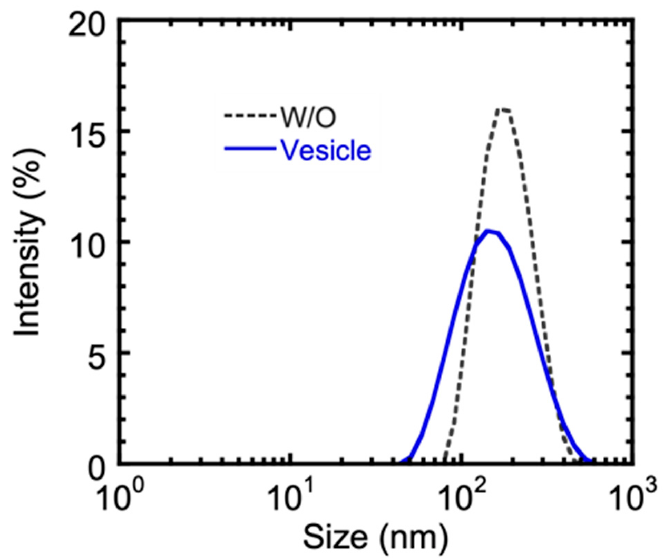
1 /O/W 2 multiple emulsion.